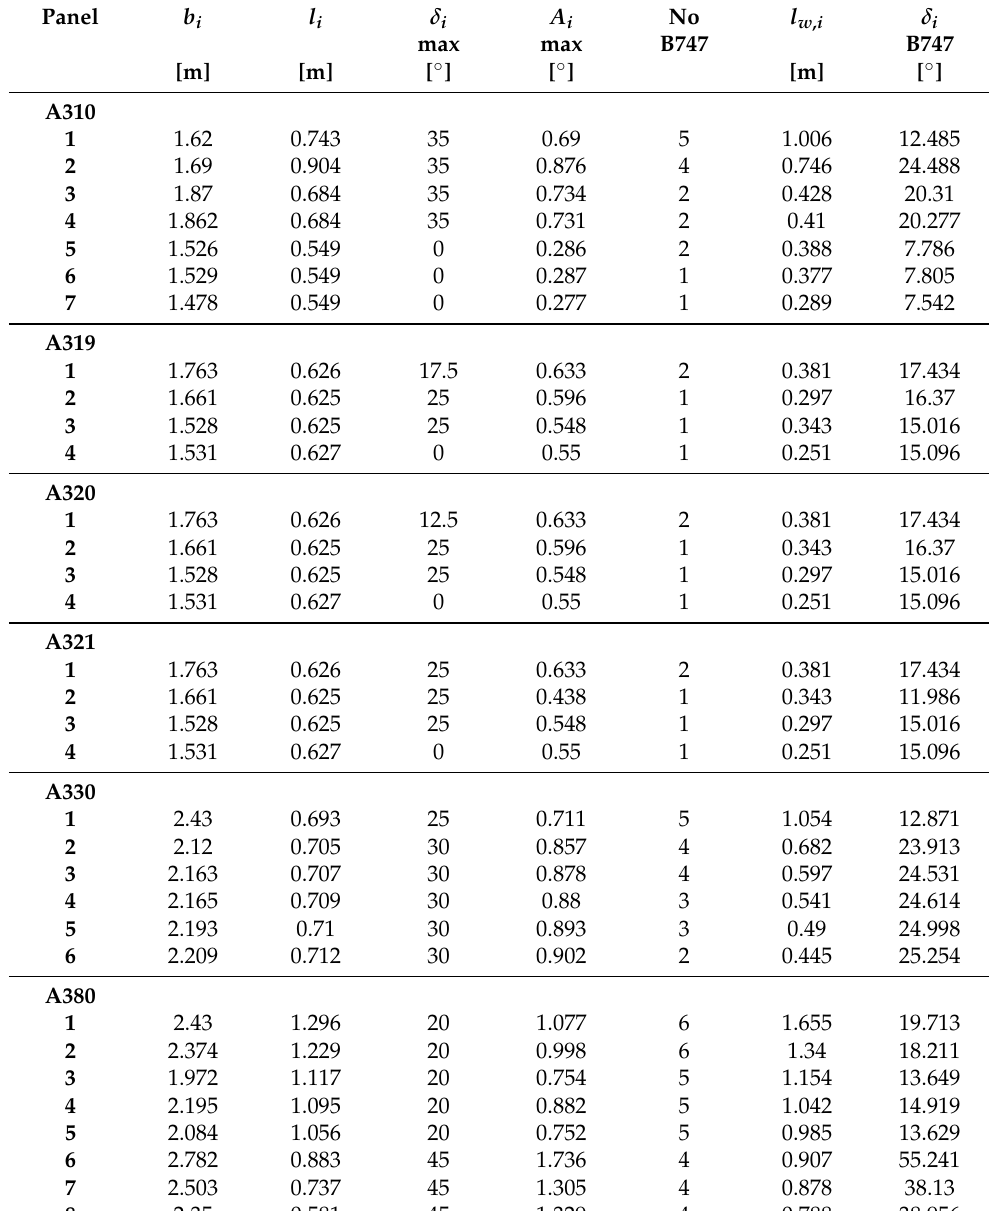
Table 2. Transfer of Airbus-specific speed brakes and their mean wing depth l w , i to the speed brakes of the B747 (No, B747) parameterized by NASA (numbered from outside to inside). Additionally, Airbus speed brake length l i , width b i , area A i , maximum speed brake angles δ i , max , and the resulting maximum speed brake angles of the corresponding B747 speed brake δ i [ ◦ ] are